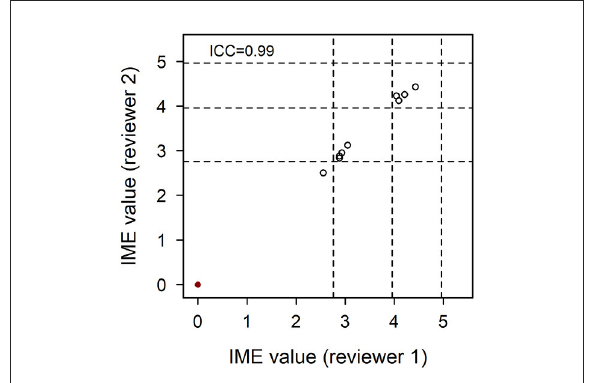
FIGURE3 Agreement of integrated metric of evidence (IME) values for 10 randomized and five higher evidence publications. Ten papers from the pool of included records were selected at random and five papers hypothesized to be of higher evidence were selected in targeted fashion. These 15 papers were individually assessed by two reviewers, blinded to each other’s scores. The correlation between IME values was 0.99, demonstrating excellent reliability of the scoring system. Horizontal dotted lines indicate the threshold IME values between negligible and low (2.76), low and intermediate (3.96), and intermediate and high (4.96) levels of evidence.